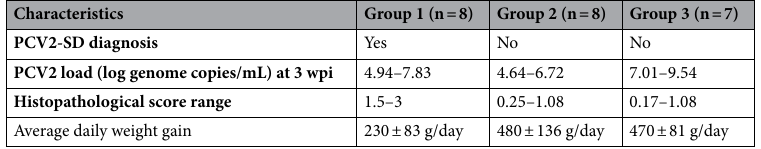
Table 1. Main characteristics of selected pigs for genetic analyses. The characteristics that were used as selection criteria of inclusion are